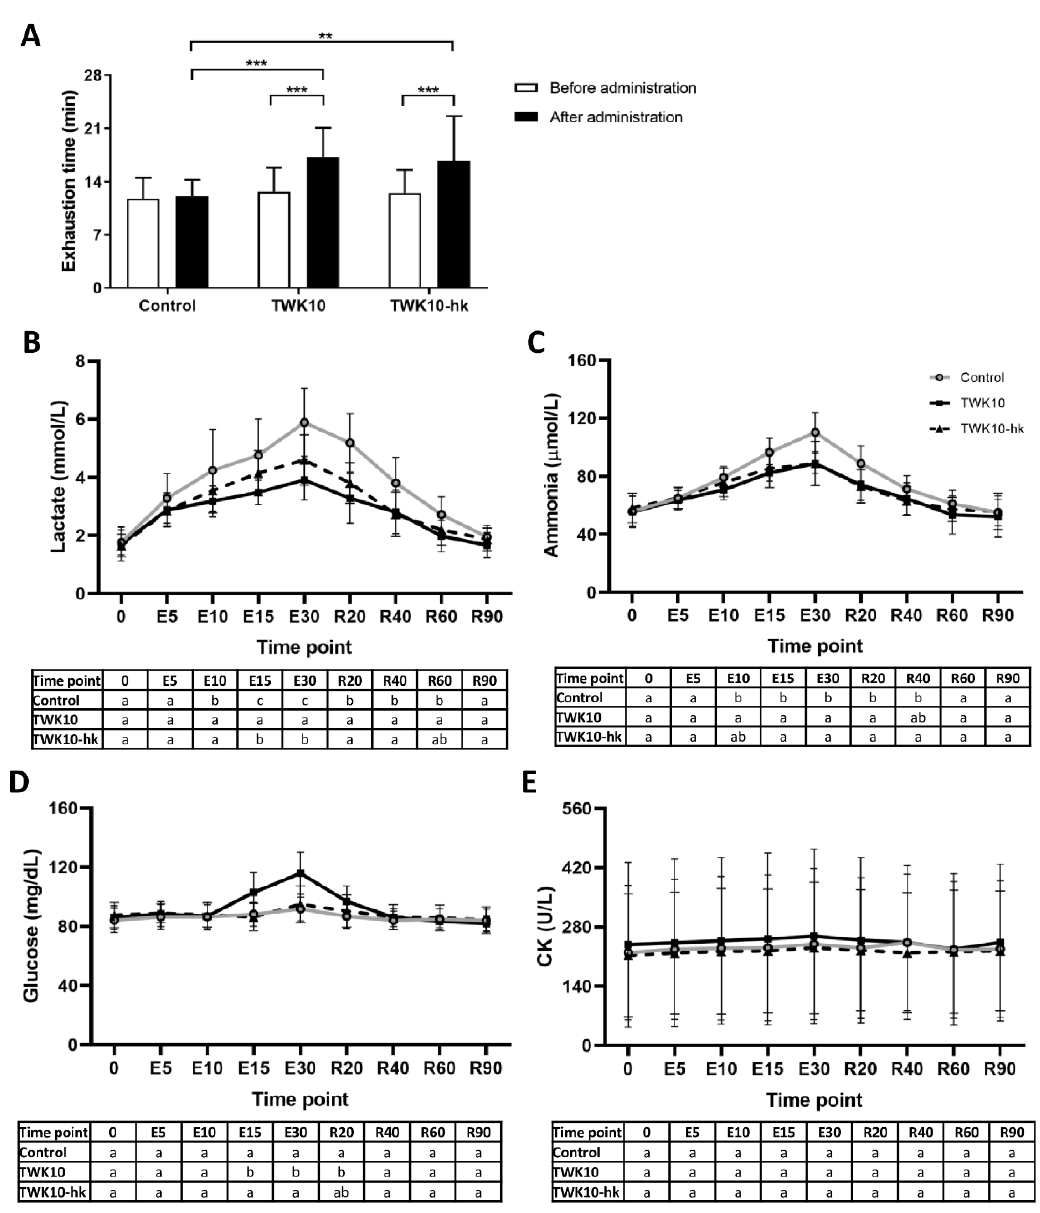
Figure 1. Effects of TWK10 on exercise endurance performance and fatigue-associated blood indicators. ( A ) Endurance performance was evaluated under 85% VO 2max exercise intensity before and after TWK10 administration. Statistical differences among groups were analyzed by two-way repeated-measures ANOVA with Tukey post-hoc test. The significance of differences between parameters before and after administration was analyzed by two-way repeated-measures ANOVA with Bonferroni post-hoc test. ** P < 0.01, *** P < 0.001. During fixed intensity and period exercise tests, blood samples were collected for ( B ) lactate, ( C ) ammonia, ( D ) glucose, and ( E ) CK measurements at the indicated time points after TWK10 administration. Data are presented as mean ± SD. Statistical differences among groups were analyzed by one-way ANOVA with Tukey post-hoc test. Different letters (a, b, c) indicate significant differences among groups at P < 0.05.